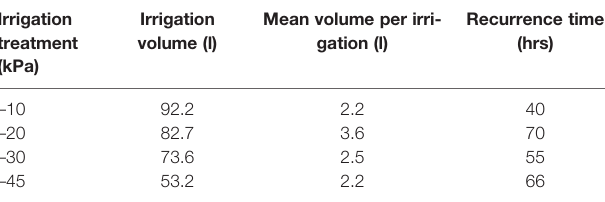
TABLE 2 | Irrigation volume (liter), mean volume of water applied per irrigation (liter), and irrigation time recurrence (hour) for each irrigation treatment. Irrigation